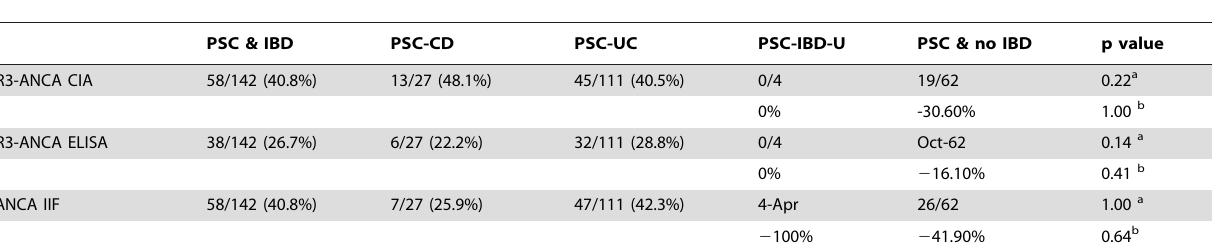
Table 4. Frequency of PR3-ANCA in PSC & IBD